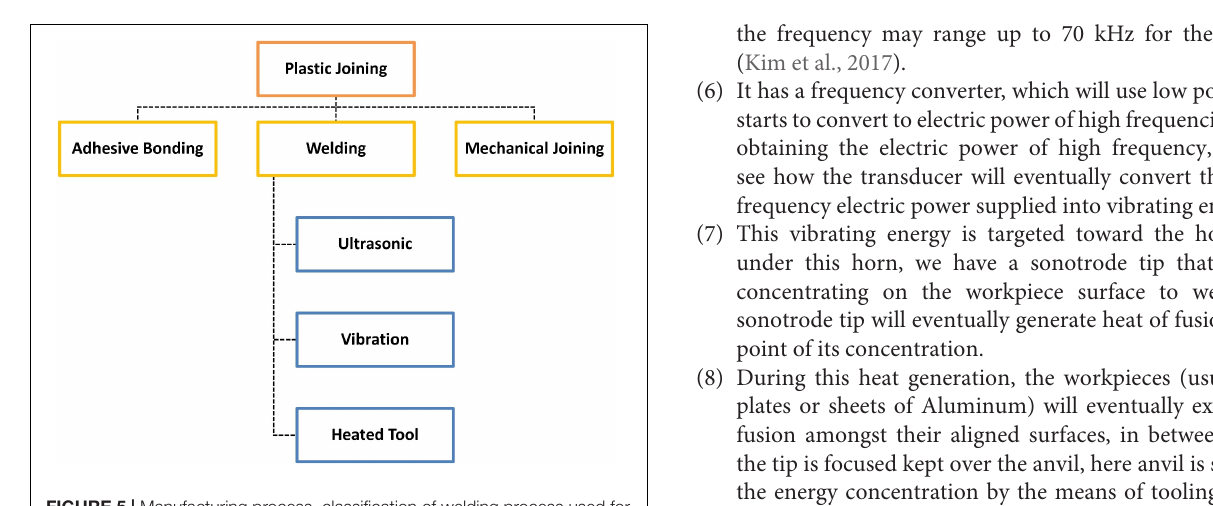
FIGURE 5 | Manufacturing process, classification of welding process used for polymeric